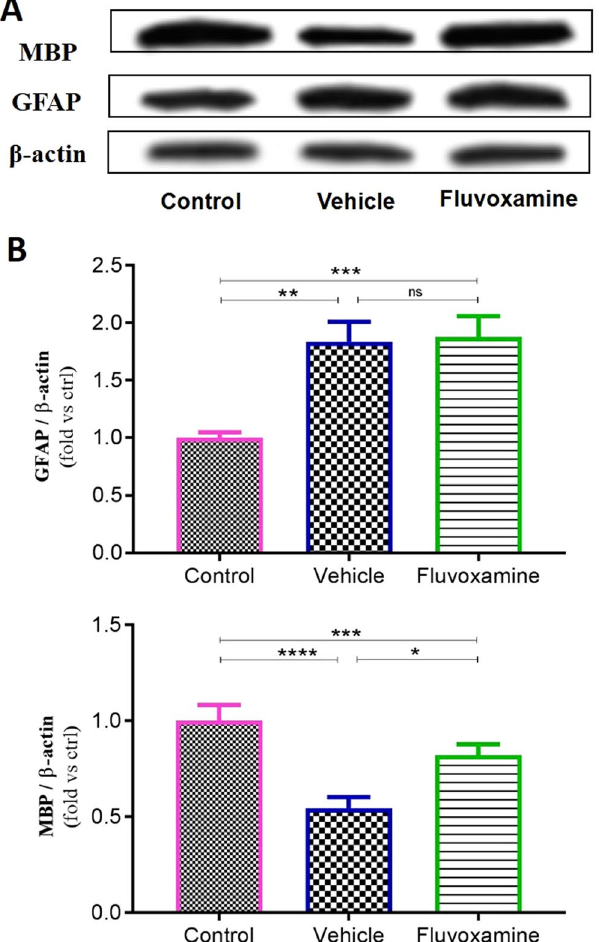
Figure 10. Western blot assessment of glial fibrillary acid protein (GFAP) and myelin basic protein (MBP). ( A ) Representative western blot of GFAP and MBP protein expression in the spinal cord. β actin was used as housekeeping control. ( B ) Quantitative analysis was performed using LabWorks Software. Values are expressed as the Mean ± SEM. Each group included 7 rats (n = 7). Statistical analyses were performed by one-way analysis of variance followed by Tukey’s test. Significance is indicated by * p < 0.05, ** p < 0.01, *** p < 0.001 and **** p < 0.0001.